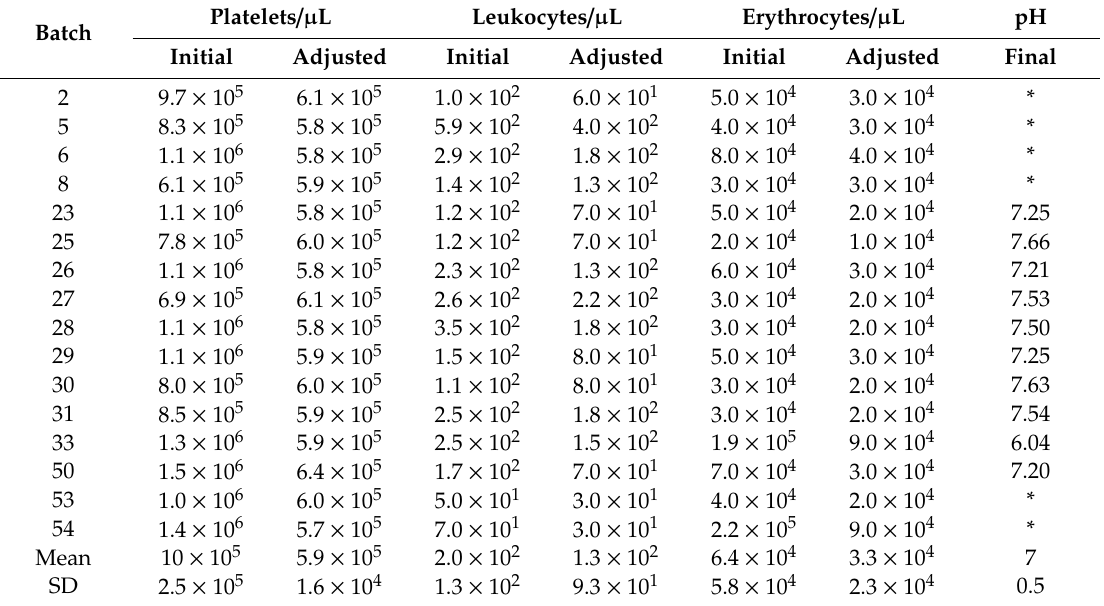
Table 1. Characterization of cellular populations (platelets, erythrocytes, leukocytes) and corresponding pH values of di ff erent hPL batches from LPP pools ( n = 3 donors, O +